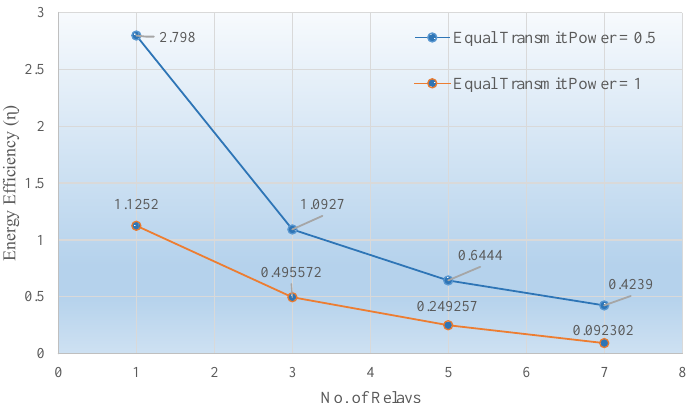
Figure 6. Energy efficiency vs. number of relays for target BER = 10 − 5 , code rate 1/2, codeword length n = 648, and 4-QAM.